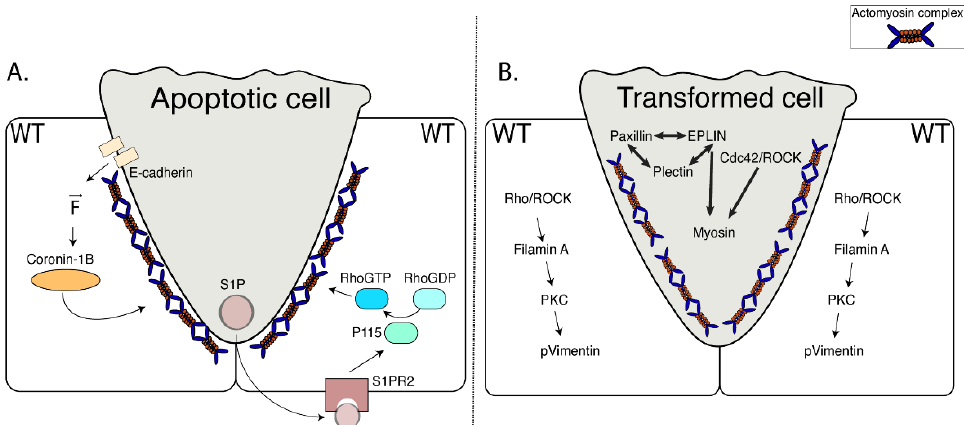
Figure 2. Types of extrusion. ( A ) Apoptotic cell extrusion. There are two known pathways for apoptotic cells to elicit extrusion responses in their nonapoptotic neighbors. [Left side] When a cell undergoes apoptosis, it becomes hypercontractile. This contractile force is sensed by its healthy neighbors through E ‐ cadherin which leads, in turn, to assembly of an actomyosin complex through coronin ‐ 1B. [Right side] The apoptotic cell releases S1P. S1P binds to S1P 2 receptors present on the healthy neighbors of the dying cell; this ultimately activates RhoA through a signal transduction pathway that involves p115 RhoGEF. The active form of RhoA mediates assembly of actomyosin complex in the neighbors. ( B ) Oncogenic cell extrusion. Depending on the type of oncogene expressed, a transformed cell elicits distinct signaling pathways which potentially converge to generate biomechanical changes. Activation of the Cdc42 / ROCK signaling pathway and upregulation of cytoskeletal ‐ interacting proteins (e.g., EPLIN, paxillin, and plectin) enhance contractility in the transformed cell. Simultaneously, in the neighboring wild ‐ type cells, activation of the RhoA/ROCK signaling pathway upregulates other cytoskeletal proteins (e.g., Filamin A, vimentin). Mechanisms triggered in both the transformed and wild-type cells display mutual coregulation.